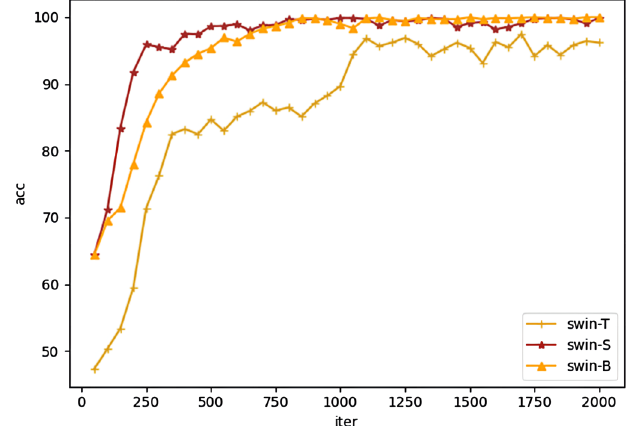
Figure 10. Comparison of accuracy for different models.